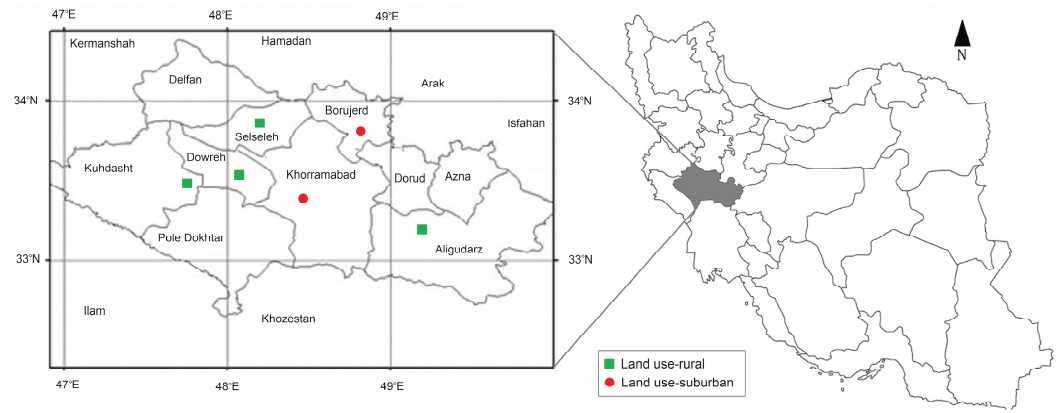
Figure 1. Trapping sites of the mosquitoes in this study, 2017–2018.